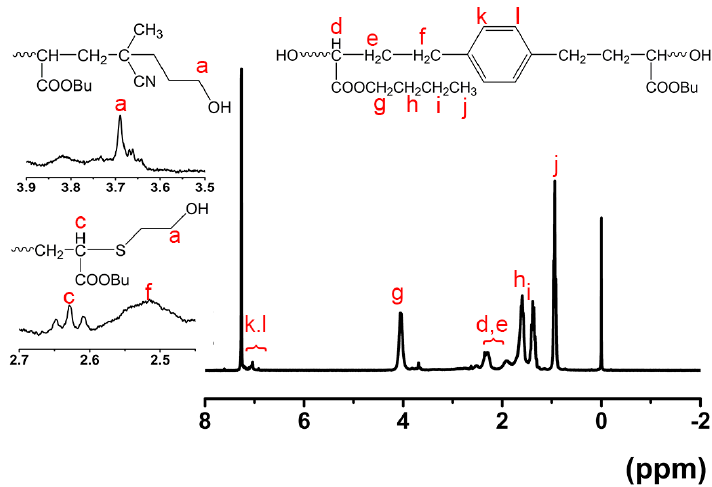
Figure 3. 1 H NMR spectrum of the poly(butyl acrylate) (PBA) synthesized by DITP of the n -BA with feed molar ratio of [ n -BA]/[ACPO]/[DIX] = 16/0.08/1 at 60 °C for 24 h ( M n,GPC = 3200 g/mol). ACPO: